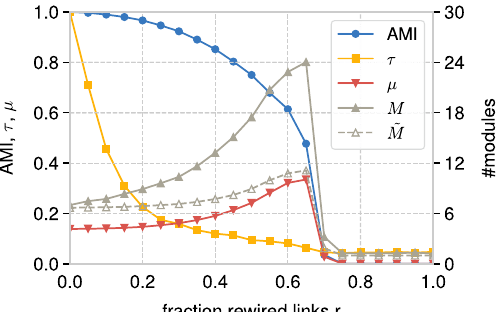
Fig. 4 Results under rewiring of an LFR network. For each fraction of rewired links, r , we infer the community structure with Infomap and compute map equation centrality scores. We report AMI with the ground truth partition, correlation with the node ranking under the ground truth partition, τ , the mixing, µ , as well as the number of detected communities M and effective number of communities ˜ M . The reported values are averages over 100 rewirings for each